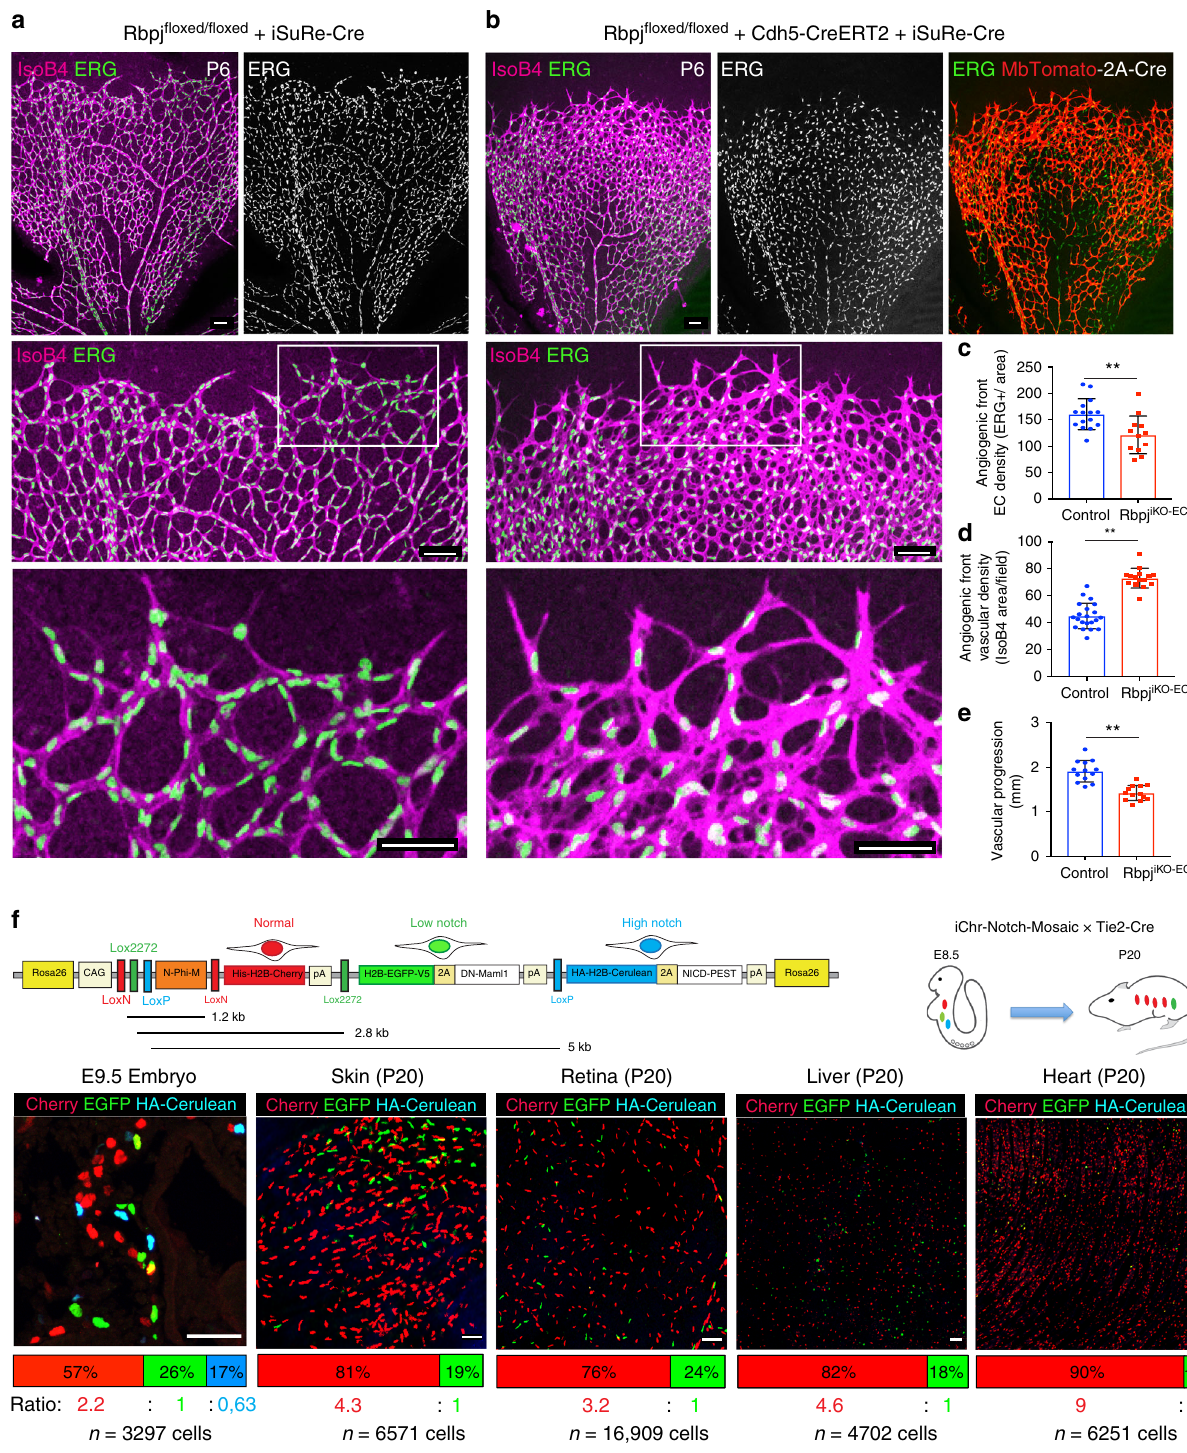
Fig. 1 ECs with low- or high-Notch signalling are outcompeted during vascular development. a , b Confocal micrographs of the postnatal mouse retina vasculature showing that the full deletion of the Rbpj gene from P1 to P6 during retina angiogenesis, results in an increase in endothelial surface and sprouting (isolectinB4) and a decrease in the number of ECs (ERG + ) and vascular progression. Cells with deletion of Rbpj from P1 to P3 are usually not found in arterial and peri-arterial endothelium at P6. See details of the iSuRe-Cre allele in Supplementary Fig. 1c – e. Scale bars, 80 μ m. c – e Comparison of indicated parameters in large microscopic fi elds of control ( n = 5) and mutant ( n = 4) mice. f The iChr-Notch-Mosaic and Tie2-Cre mouse lines were crossed to generate fl uorescent and genetic mosaics starting at E8.5 in growing ECs. Tissues of mice ( n = 4) aged 20 days (P20) were analysed for the presence of Cherry, EGFP or HA-Cerulean cells. Comparison of the P20 ratios to the baseline/initial recombination ratio determined in E9.5 embryos ( n = 4) or ES cells (see also Supplementary Fig. 2), shows that ECs with low Notch (EGFP + ) or high Notch (HA-Cerulean + ) are outcompeted during vascular development. Error bars indicate StDev; ** p < 0.005. Two-tailed unpaired t test. Source data are provided as a Source Data fi le. Scale bars, 50 μ